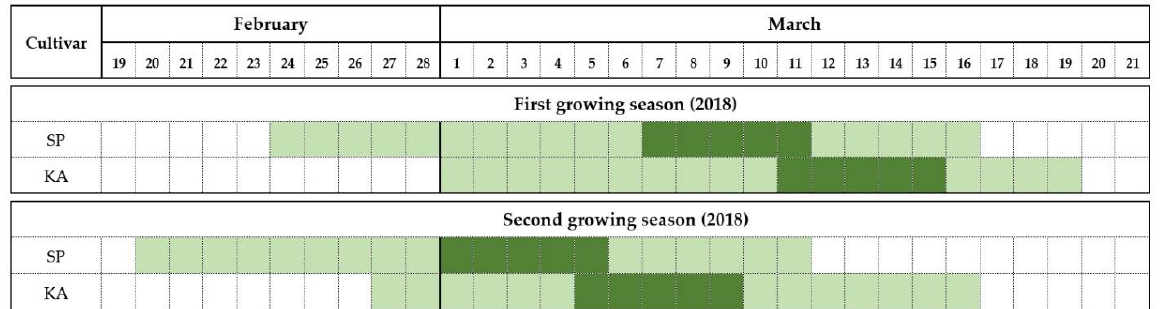
Figure 1. Flowering period of the two plum cultivars ‘Satluj Purple’ (SP) and ‘Kala Amritsari’ (KA) measured in 2018 and 2019. The light green indicates the flowering time, defined as the period between the stages “10% opened flowers” (BBCH stage-61) and “100% petal fall” (BBCH stage-69), whereas the dark green indicates the full bloom time defined the period when the percentage of opened flowers was between 50% (BBCH stage-65) and 70%.